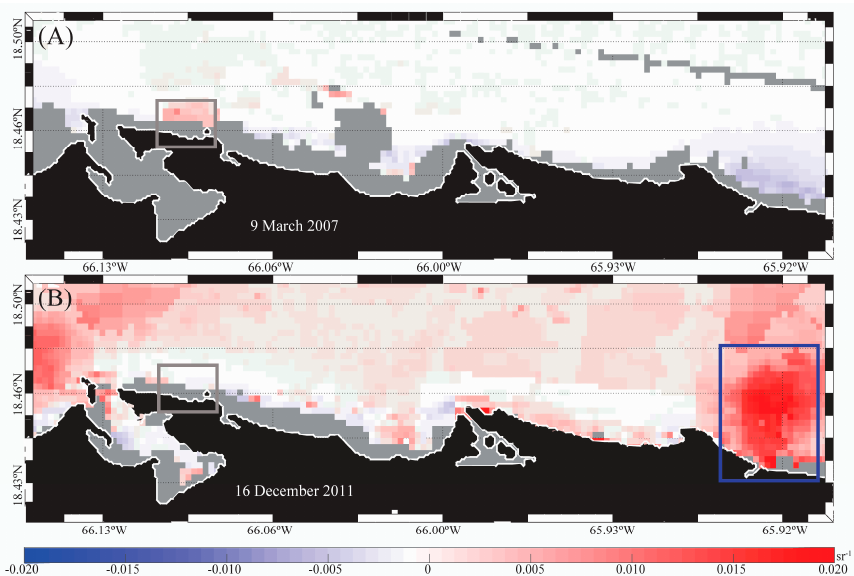
Figure 3. Anomalies of remote sensing reflectance (R rs 645 nm, 250 m spatial resolution, from the Moderate Resolution Imaging Spectroradiometer MODIS-Terra) showing Escambron Beach (gray box) water clarity anomalies three days before the beach advisories of ( A ) 9 March 2007 and ( B ) 16 December 2011. Blue box on ( B ) shows the high discharge of Rio Grande de Loiza on 16 December 2011.